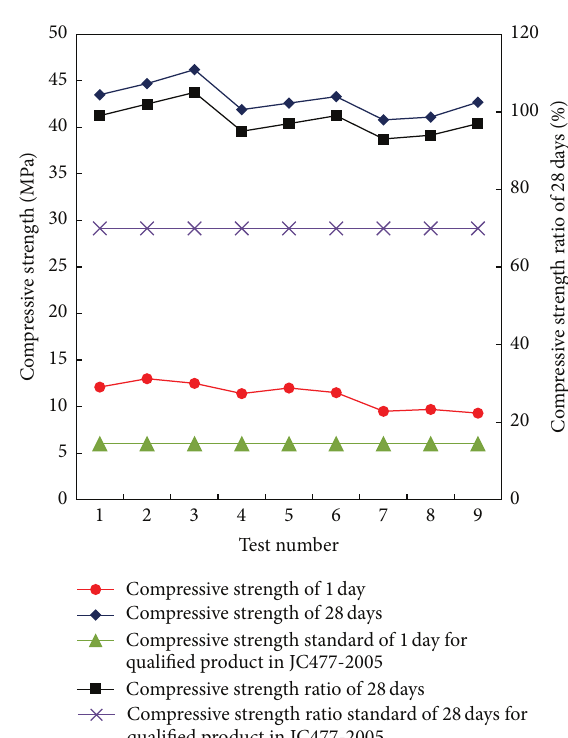
Figure 3: Setting time of orthogonal test.